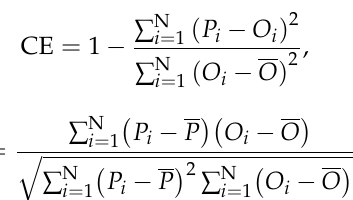
MAE (IR MAE ) was 14% to 18%. The IR RMSE and IR MAE of the mV11_GRU and